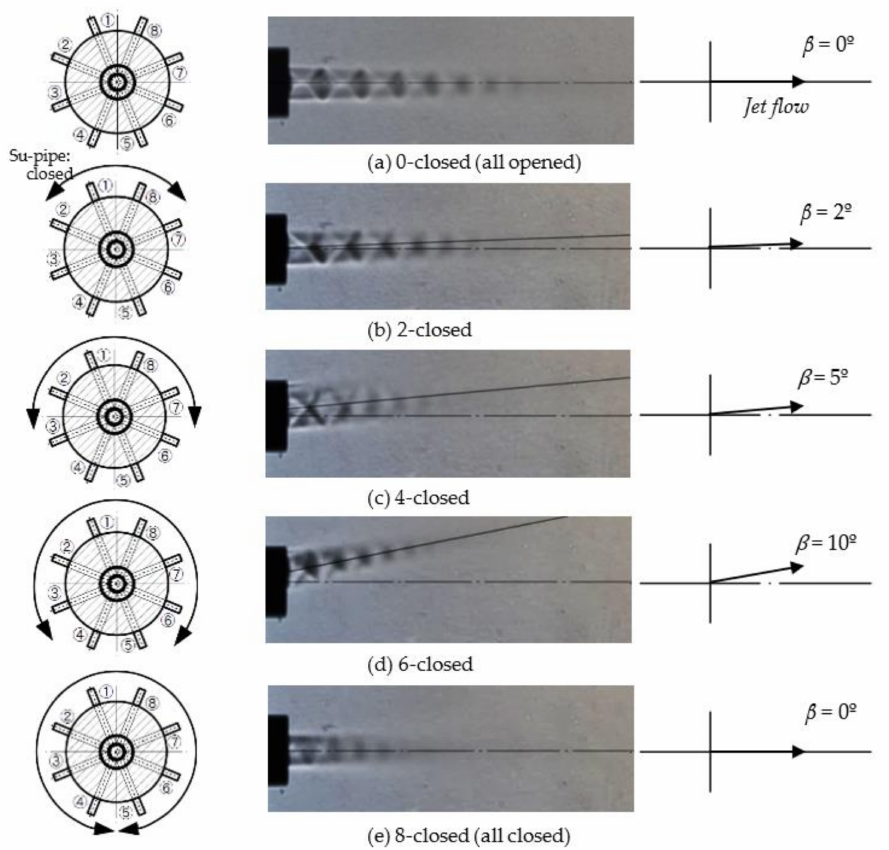
Figure 3. Visualized flow pattern of the jet issued from the FC-nozzle by Schlieren method, P 0 = 0.38 MPa (Effect of suction flow): The deflection angle of the jet was measured using visualized flow